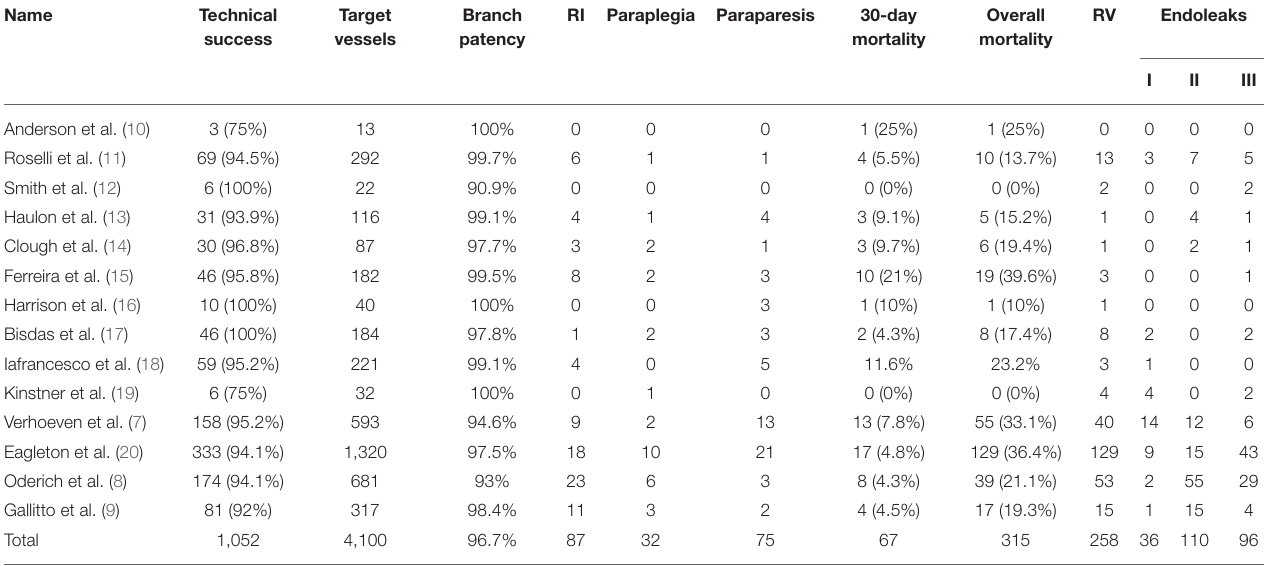
TABLE 3 | Results after the use of fenestrated and branched stent-grafts for the treatment of